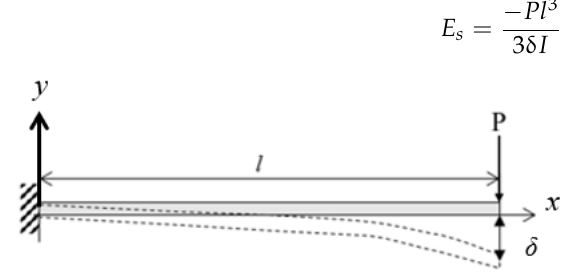
Figure 1. A uniform fixed-end cantilever beam with a static point load P supplied at the free